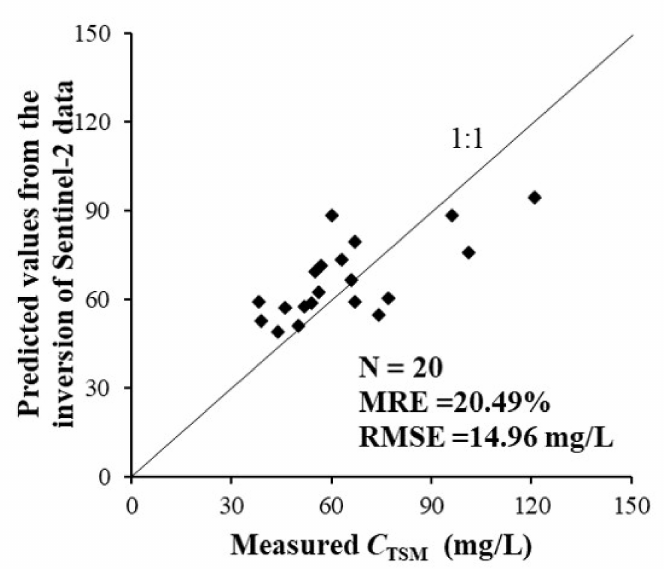
Figure 6. Comparison between the measured TSM concentration and predicted values based on the inversion of Sentinel-2